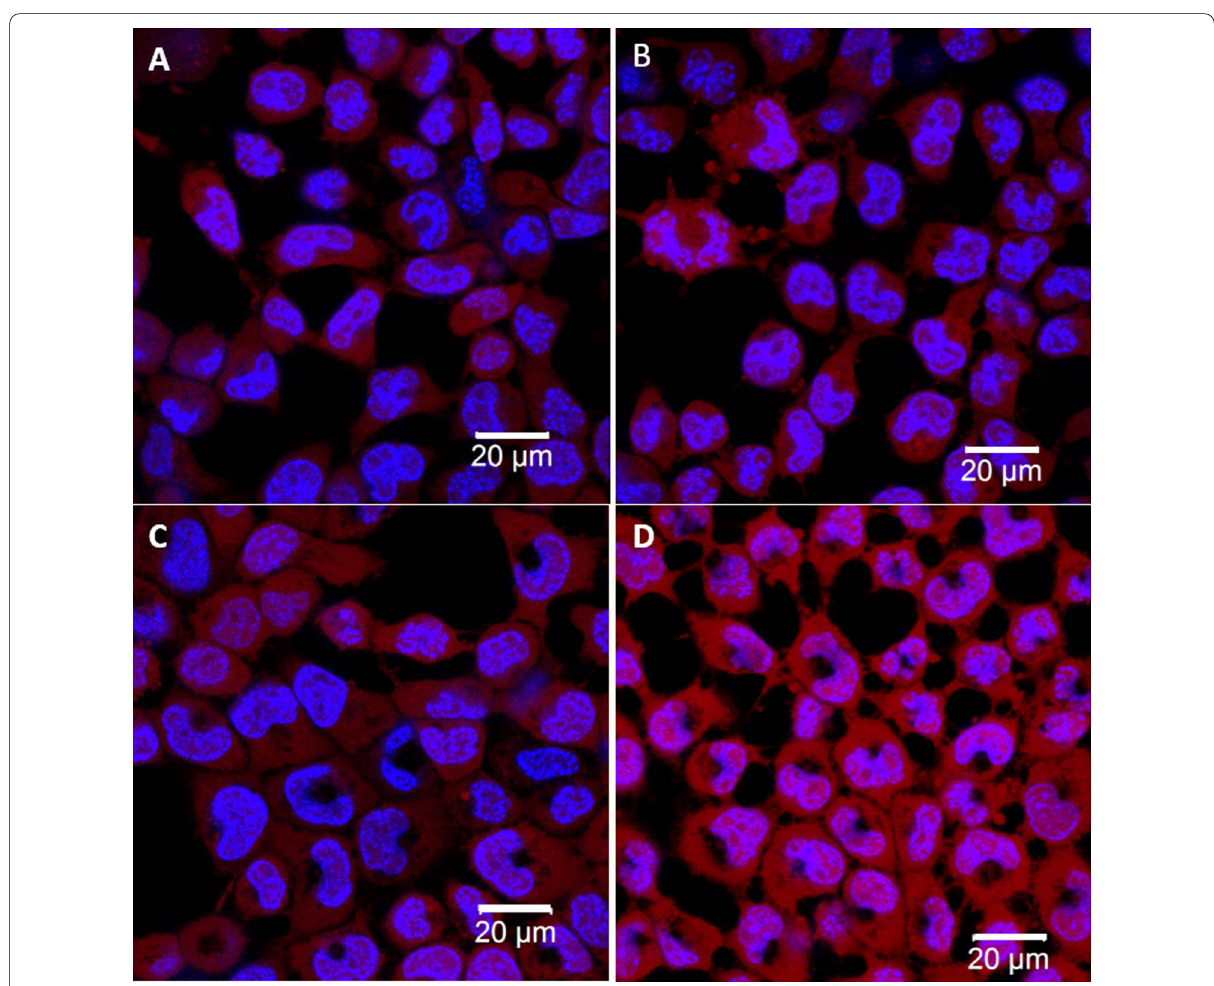
Fig. 3 Cell fluorescence images of LSCM for ROS kit irradiated by Cs‑137 with a dose of 6 Gy (magnification: controls without and with irradiation of Cs‑137, respectively. C and D the images of the GNPs‑uptake cells without and with irradiation, respectively. Kit for ROS: Carboxy‑H2DCFDA (red). Excitation laser: 488 nm; emission filter: 509–535 nm. Kit for nuclei: Hoechest 33,342